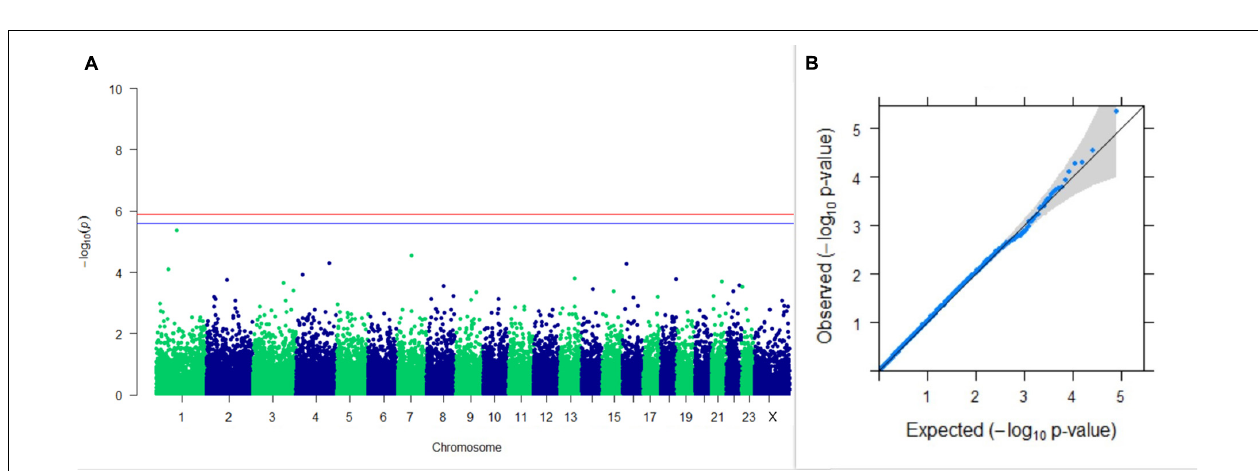
FIGURE 2 | Results of GWAS for PC2 of the test day’s milk yield. (A) Manhattan plot of genome-wide SNPs. The red line indicates the p- value threshold (expressed as –log 10 P ) corresponding to FDR-corrected p- values or q = 0.05, above which the SNPs are considered to be significantly associated with the trait, while the blue line indicates genome-wide suggestive threshold at q = 0.1. The SNPs identified on chromosome no. 24 were screened out from analysis because of stringent quality control; hence, it is not represented in the Manhattan plot. (B) Q-Q plot of the p- values.